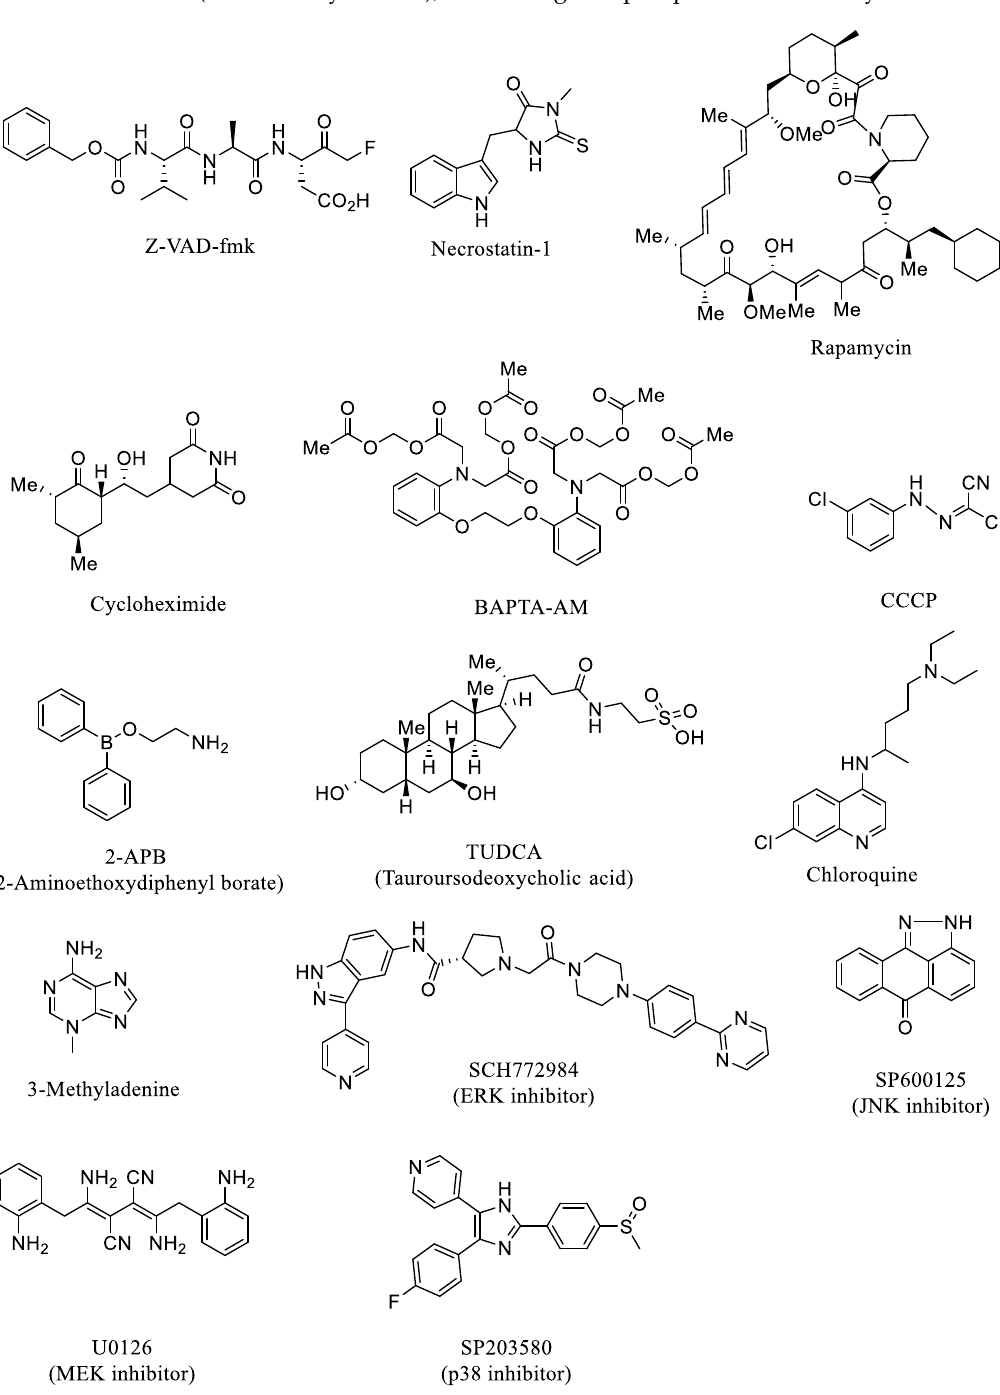
Figure 3. Chemical structures of inhibitors used in this paper.